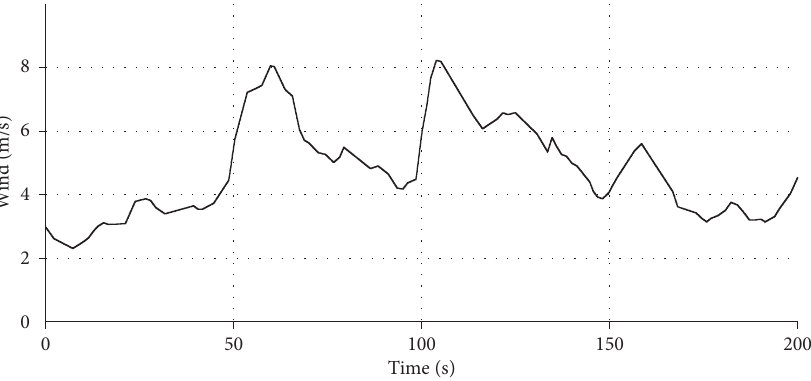
Figure 15: Real wind speed data.